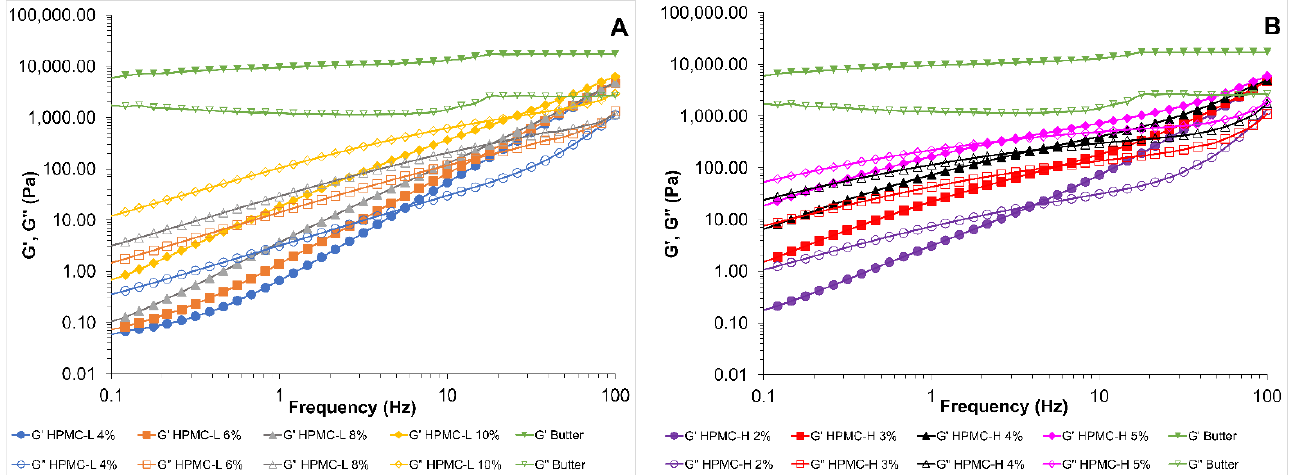
Figure 1. G’ and G” moduli of HPMC solutions and butter as a function of frequency. ( A ) HPMC-L solutions at different concentrations (4% blue circles; 6% orange squares; 8% grey triangles; 10% yellow diamond) and butter (green down-pointing triangle). ( B ) HPMC-H solutions at different concentrations (2% purple circles; 3% red squares; 4% pink triangles; 5% black diamond) and butter (green down-pointing triangle). Filled symbols correspond to storage modulus (G’) and open symbols to loss modulus (G”).